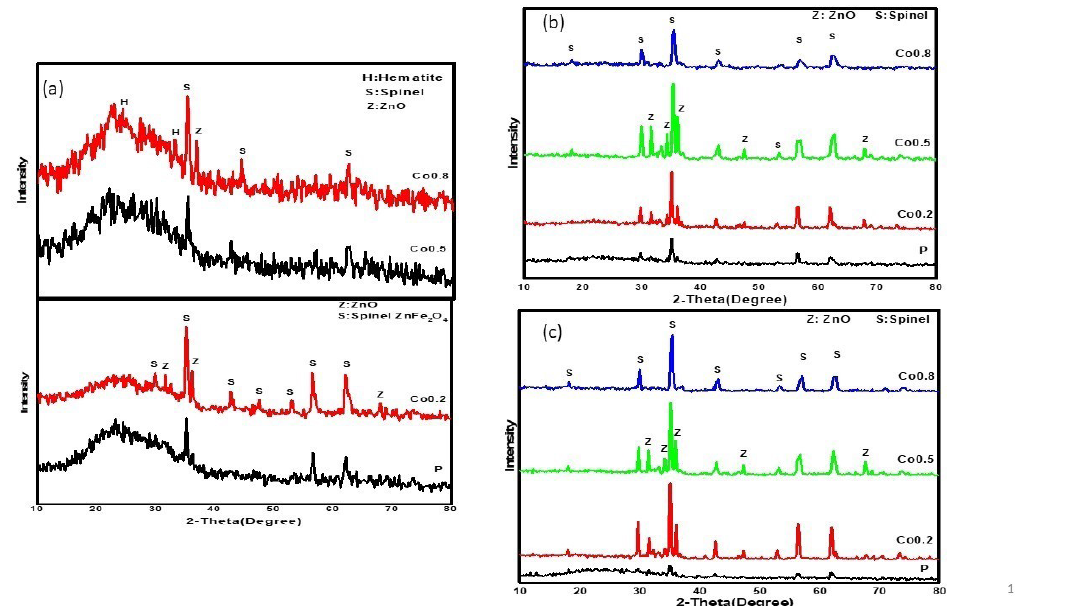
Figure 2. XRD for Cobalt-Zinc ferrites with different Co concentration prepared from EAFD by solid state method at (a) 800ºC (b) 850ºC (c)